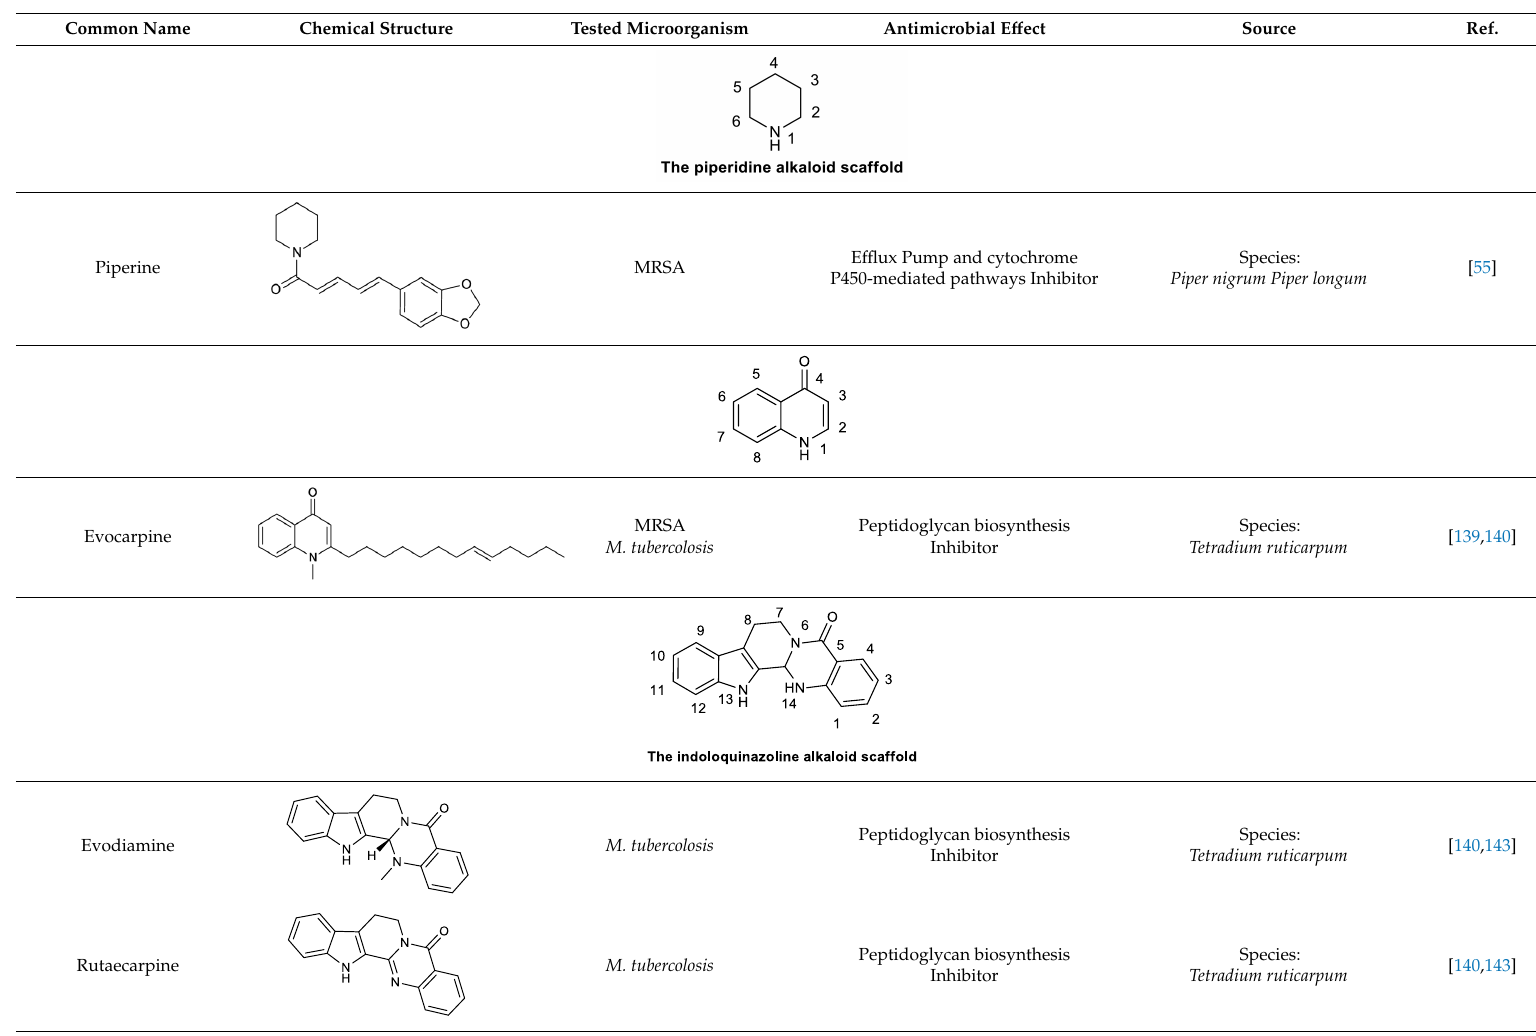
Table 5. Summary of antimicrobial activity of some classes of piperidine and quinolone alkaloids.